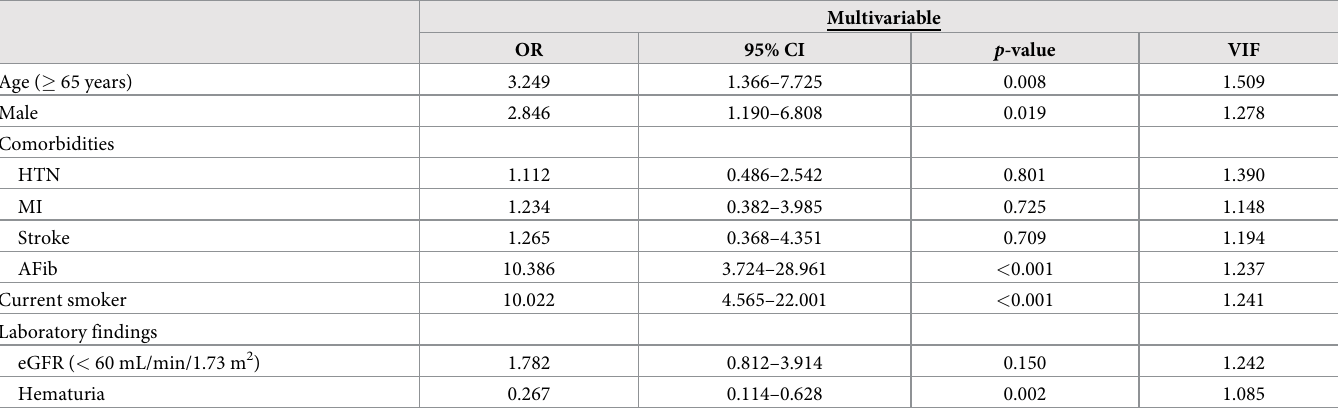
Table 3. Multivariable logistic regression analysis of predictors of renal infarction.